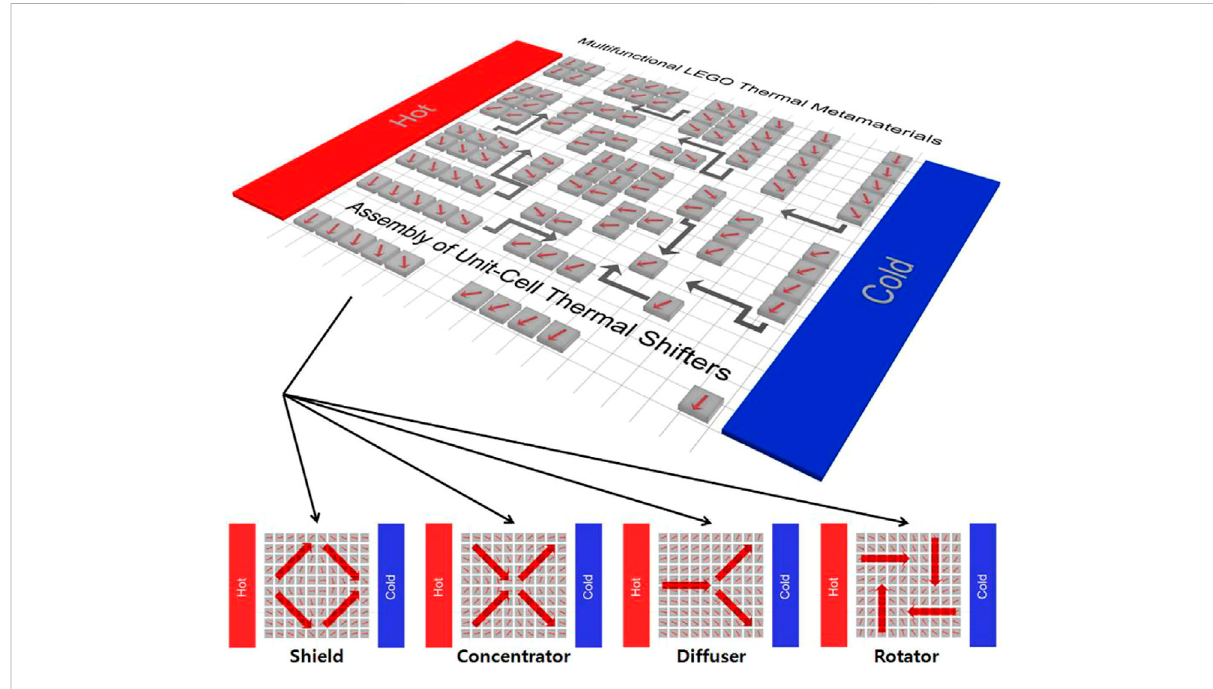
FIGURE 5 Scheme of tunable multifunctional thermal metamaterials